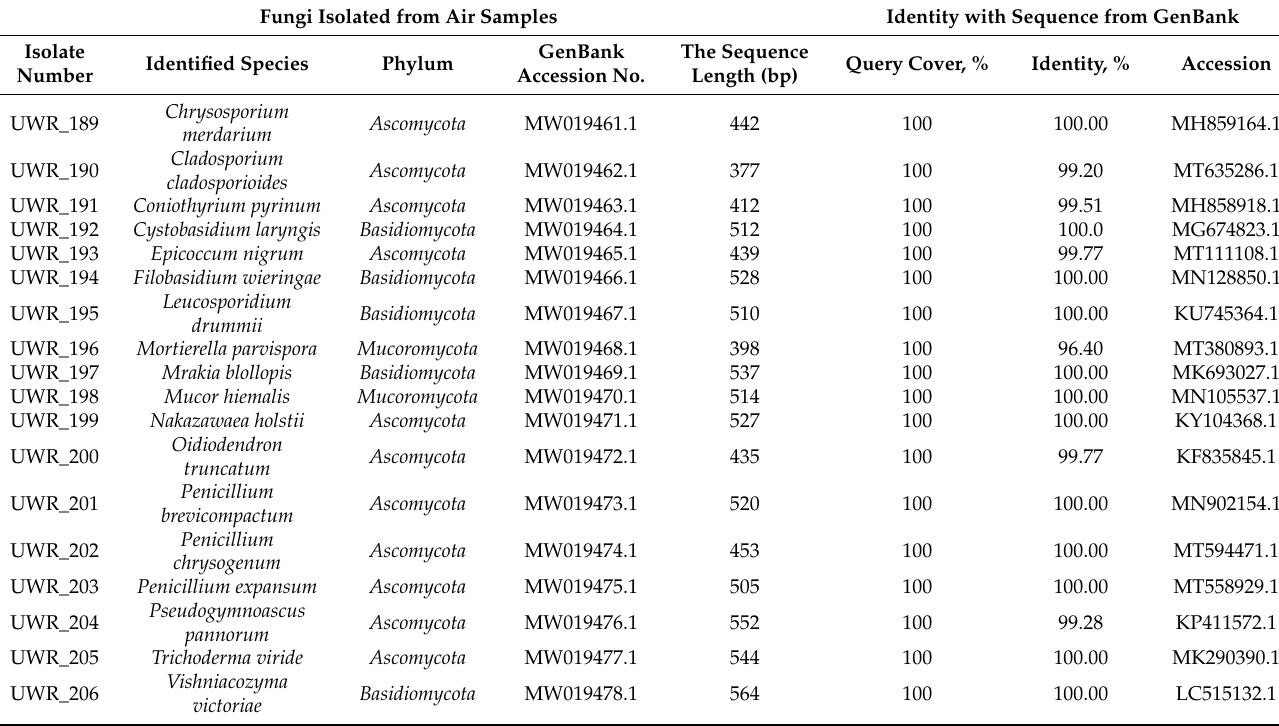
Table A1. Cultured airborne fungi detected in the Brestovsk á Cave and results of BLAST (all E values were zero). Fungi Isolated from Air